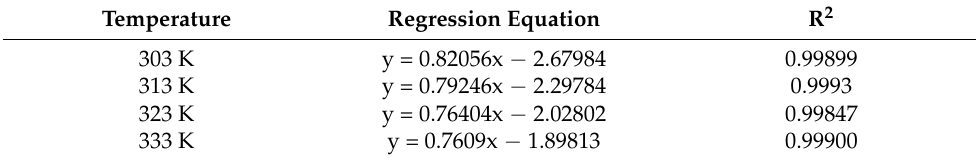
Table 4. Fitting results between ln[ − ln(1 − η )] and lnt under different temperatures. Temperature